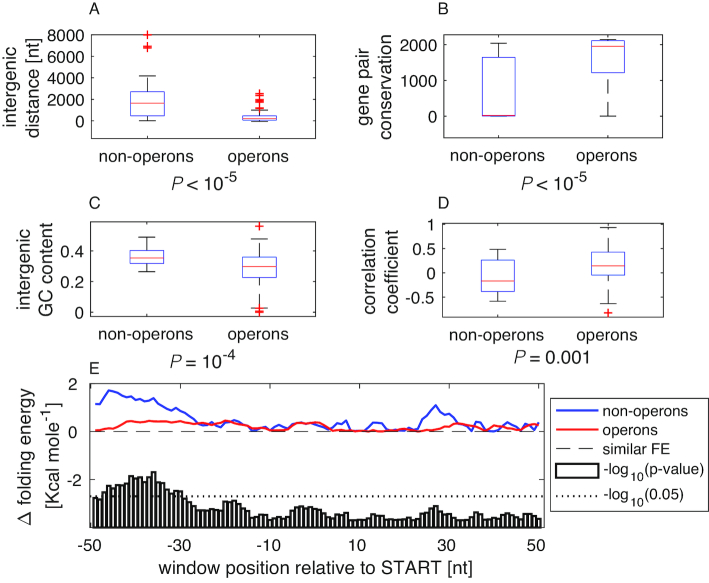
Operon sequence features. Distribution of (A) intergenic distances, (B) gene pair conservation, (C) intergenic GC content, (D) RNA structure similarity (Pearson’ correlation coefficient) among operon and non-operon gene pairs. (E) Position specific mRNA folding energy mean margin between gene pairs in absolute values. The bars represent the position specific P-value (-log10pv) comparing the OPs mean value to that of NOPs. The scale for the bar charts is not given, instead the common significance threshold is drawn (see legend). All P-values were computed using an unsupervised standard permutation test (see ‘Materials and Methods’ section: Permutation test). All significant P-values were confirmed using the Benjamini & Hochberg False Discovery Rate (FDR) procedure (62), \documentclass[12pt]{minimal}
\usepackage{amsmath}
\usepackage{wasysym} 
\usepackage{amsfonts} 
\usepackage{amssymb} 
\usepackage{amsbsy}
\usepackage{upgreek}
\usepackage{mathrsfs}
\setlength{\oddsidemargin}{-69pt}
\begin{document}
}{}${N_{{\rm OP}}}$\end{document} = 137, \documentclass[12pt]{minimal}
\usepackage{amsmath}
\usepackage{wasysym} 
\usepackage{amsfonts} 
\usepackage{amssymb} 
\usepackage{amsbsy}
\usepackage{upgreek}
\usepackage{mathrsfs}
\setlength{\oddsidemargin}{-69pt}
\begin{document}
}{}${N_{{\rm NOP}}}$\end{document} = 76.